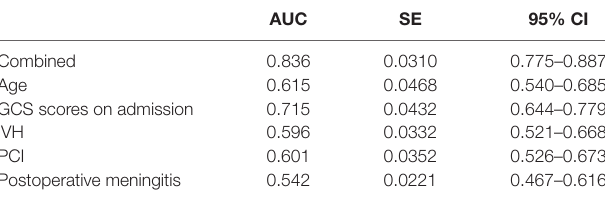
Table 3 | The AUCs under the ROC curves.